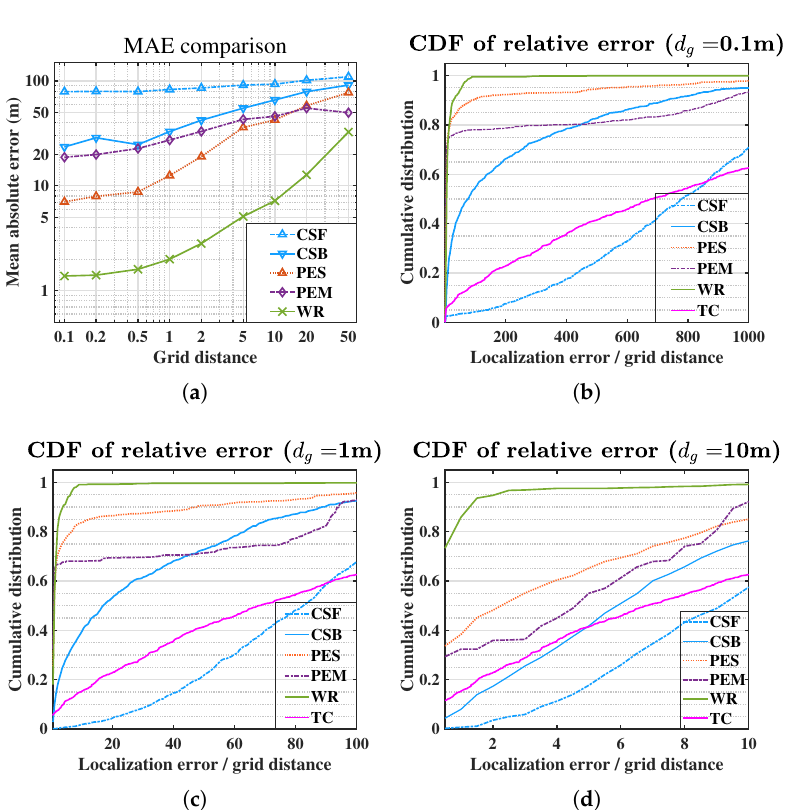
Figure 8. Experiment results: ( a ) MAE comparison; ( b ) CDF of relative error at d g = 0.1 m; ( c ) CDF of relative error at d g = 1 m; ( d ) CDF of relative error at d g = 10